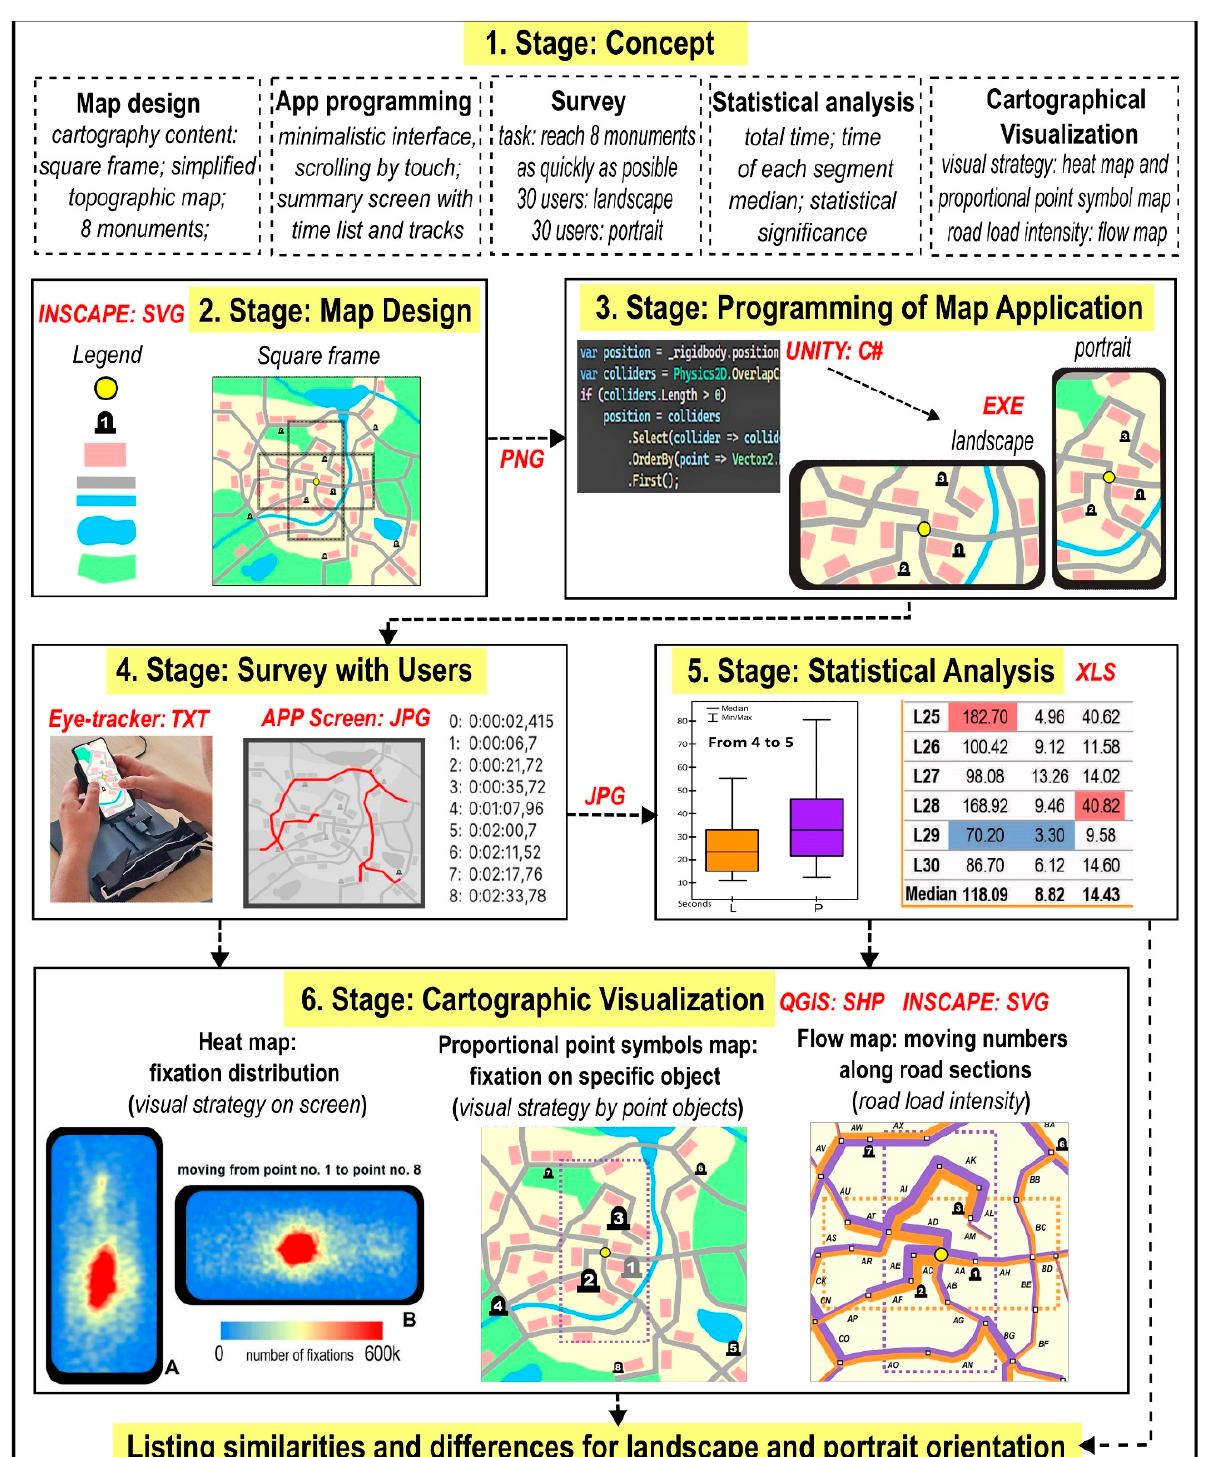
Figure 1. Graphical scheme with six research stages.